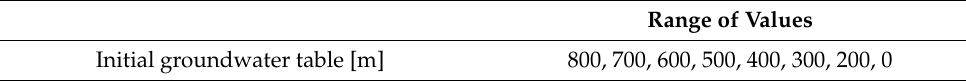
Table 4. The range of values for the groundwater table in